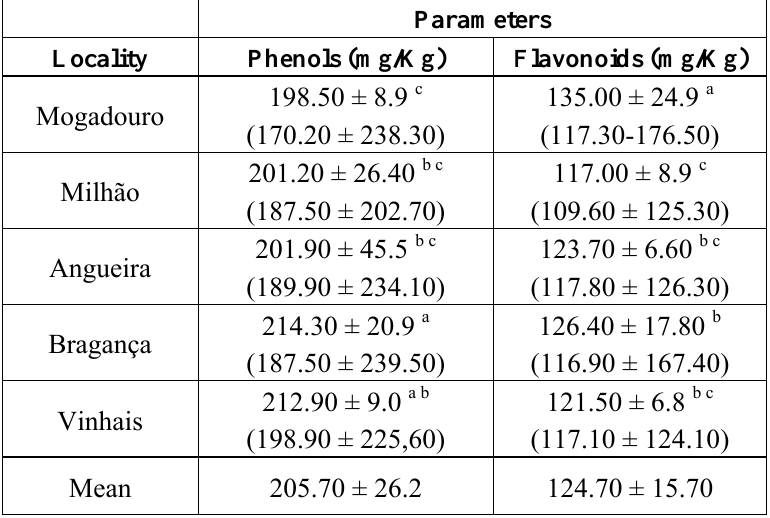
Table 3. Differences in phenols and flavonoids mean concentrations among regions. Standard deviation values are shown in